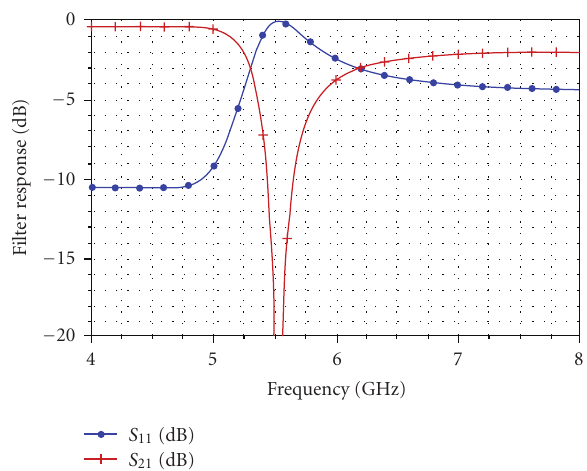
Figure 3: Frequency response of an FBAR coupled to a microstrip hairpin with side coupling.